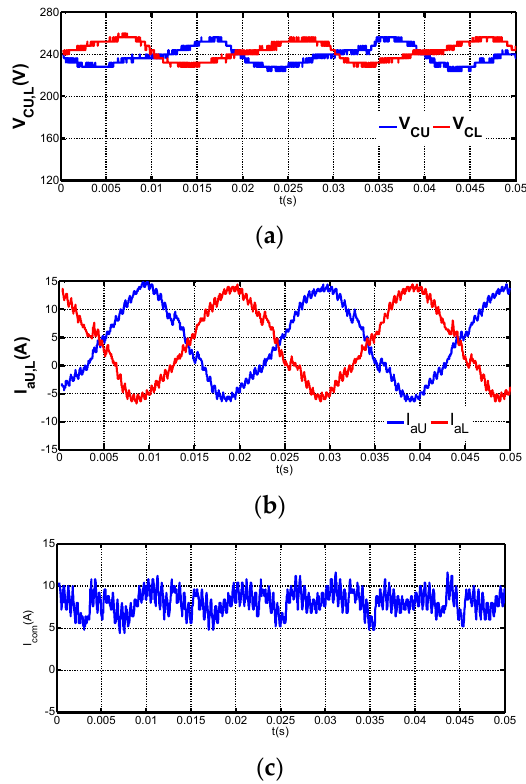
Figure 17. Experimental waveforms of the 3-cell MMC that employs internal Scheme-B: ( a ) upper and